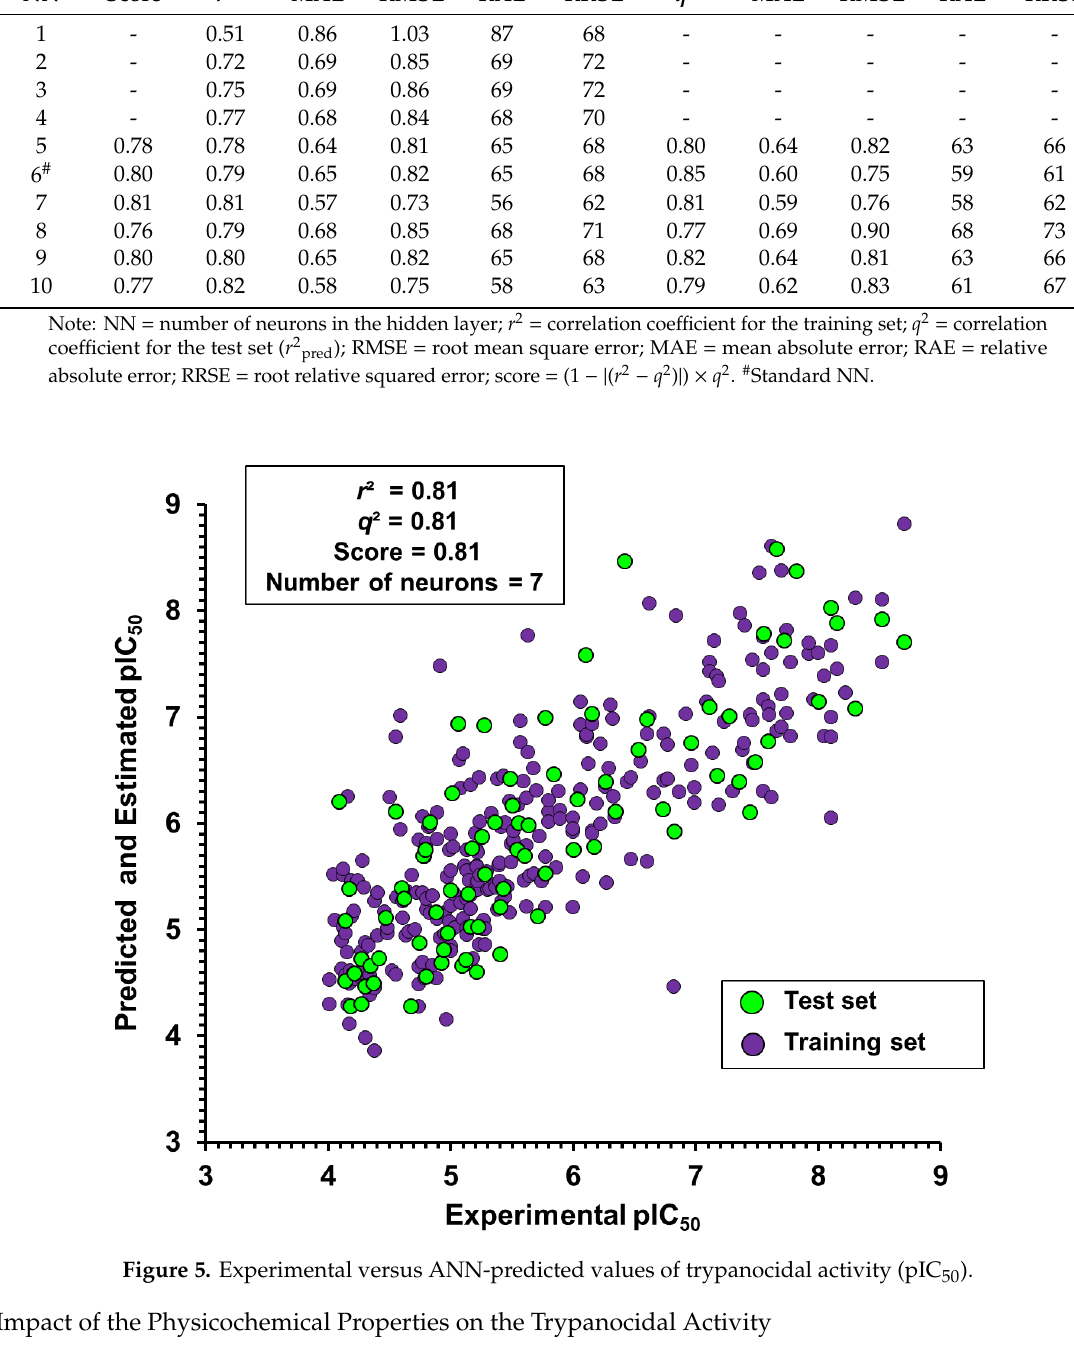
Table 3. Performance of the ANNs as a function of the number of neurons in the hidden layer. Training Set